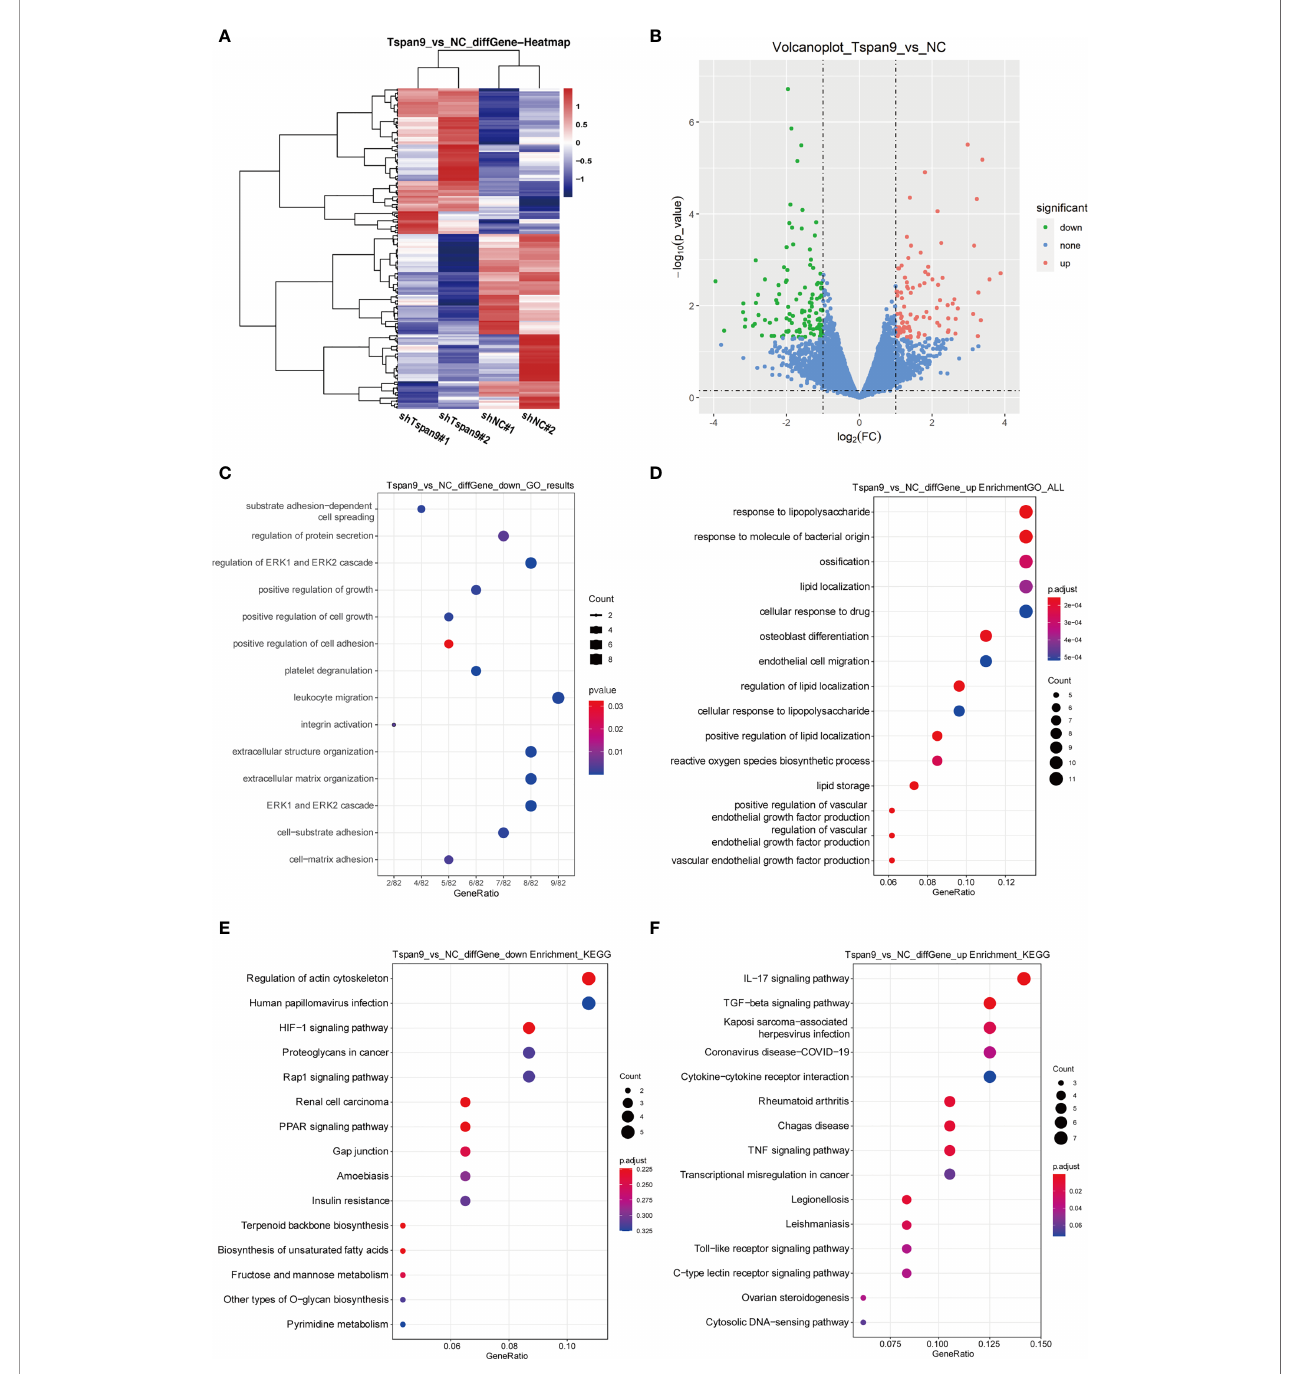
FIGURE 3 | RNA-seq-mediated identi fi cation of the biological roles of Tspan9 in OS cells. (A) Heatmaps demonstrating DEGs identi fi ed via RNA-seq in HOS cells in which shTspan9 or shNC were stably expressed. (B) DEGs (n=211) are represented in a volcano plot, including 96 upregulated DEGs (red) and 115 downregulated DEGs (green), with DEGs having been identi fi ed using the following criteria: adjusted log fold-change ≥ 1 and P ≤ 0.05. (C, D) GO analyses of DEGs identi fi ed following Tspan9 knockdown were conducted, with top enriched biological processes, molecular functions, and cellular components being shown in a bubble chart in which darker coloration is indicative of more signi fi cant enrichment. (E, F) KEGG pathway enrichment analyses of identi fi ed DEGs were conducted, with the results being shown in a bubble chart in which bubble size is proportional to the number of DEGs in a given pathway, and the bubble color is indicative of P-value signi fi cance (red = signi fi cant, blue = non-signi fi cant). DEGs, differentially expressed genes; GO, Gene Ontology; KEGG, Kyoto Encyclopedia of Genes and